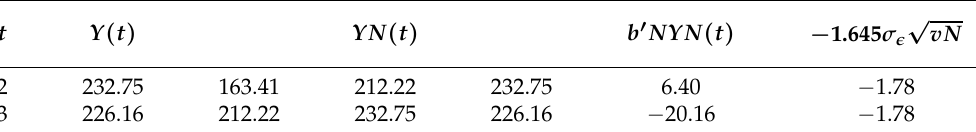
Table 11. Recursive procedure for t ≥ N − 1.